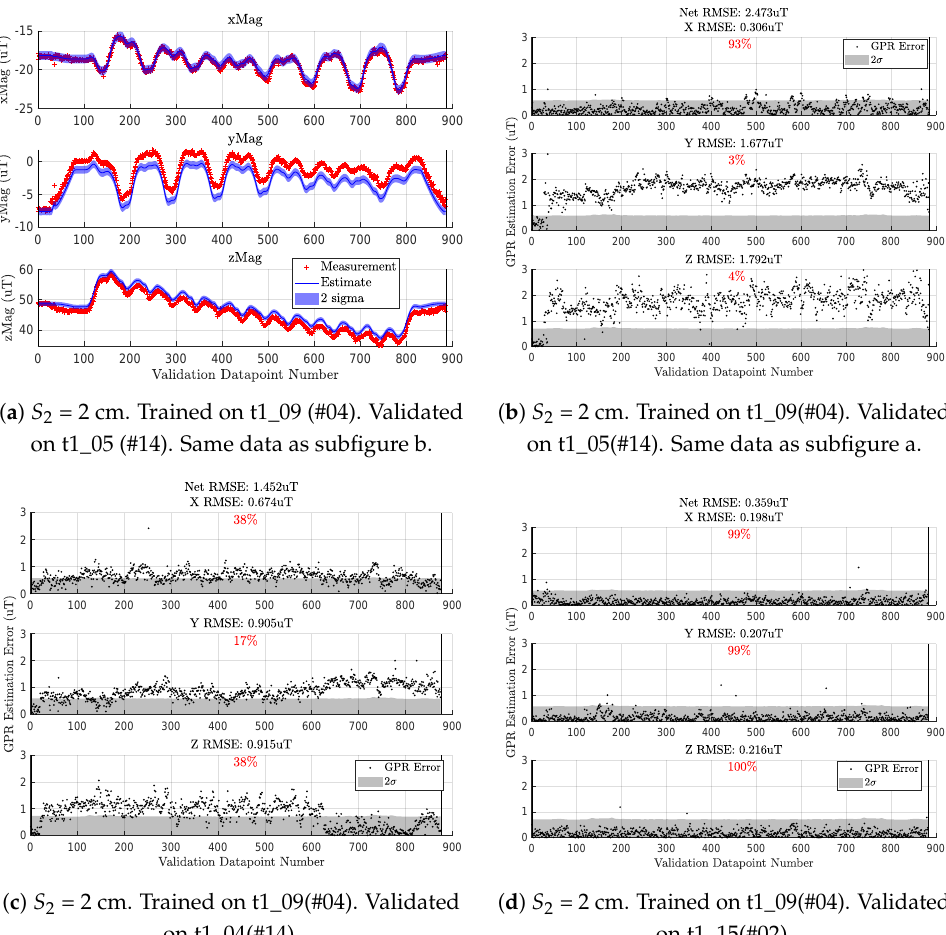
on t1_15(#02). Figure 8. Flight -by-flight variations shown through three validation tests. Figure 8b depicts a black dot as the error between the red cross and blue line while the GPR’s 2 σ uncertainty is the gray shading. Here, we plot the absolute value of the error since the sign of the error does not indicate anything of interest. The percentage in the grayscale plots depicts how often the black dots (GPR error) are within the gray shading (GPR’s 2 σ